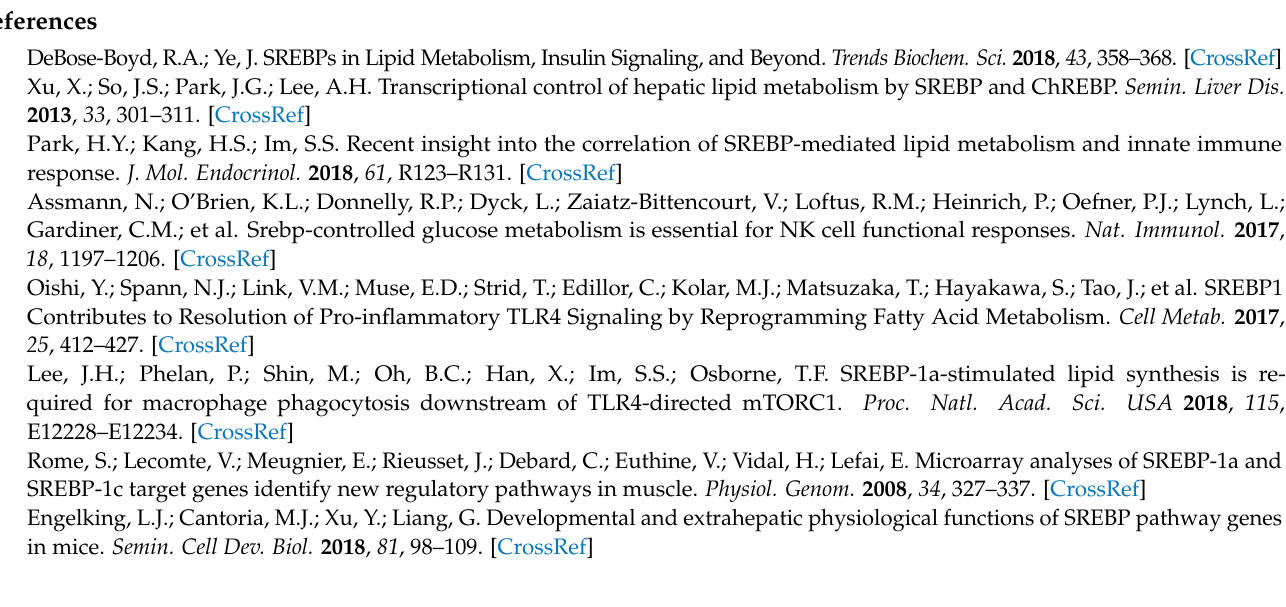
Table S2: Description of selected DEGs. Table S3: Description of genes with putative functions. Table S4: Description of filtered genes using the STRING